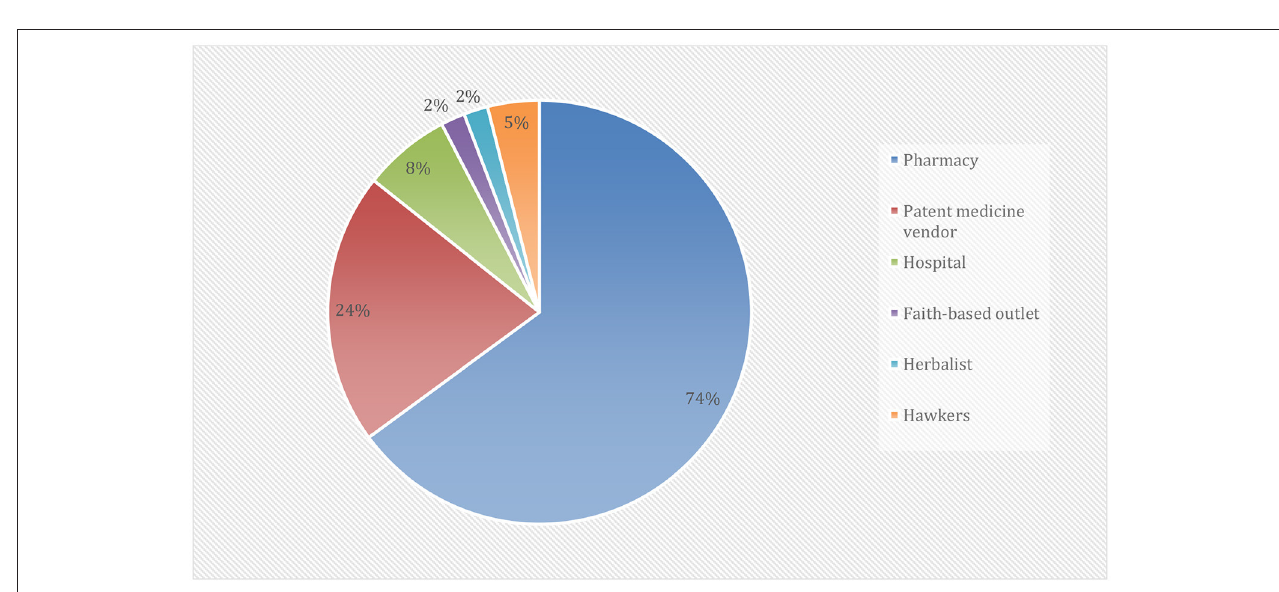
FIGURE 3 | Source of medicine used for